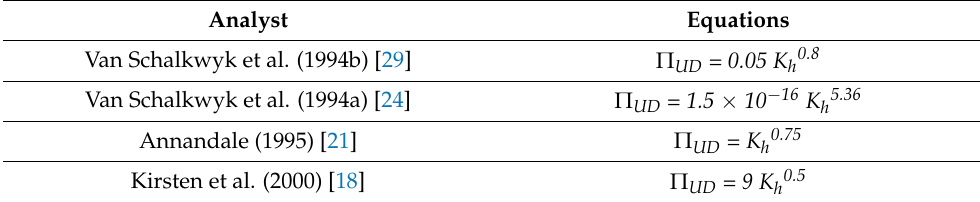
Figure 4. ( a ) Original dataset as presented in the study of Van Schalkwyk [24]; ( b ) after inclusion of data from Moore [24]; ( c ) scour threshold line presented by Annandale; ( d ) comparison of scour threshold lines. Table 2. Scour threshold equations by different researchers.